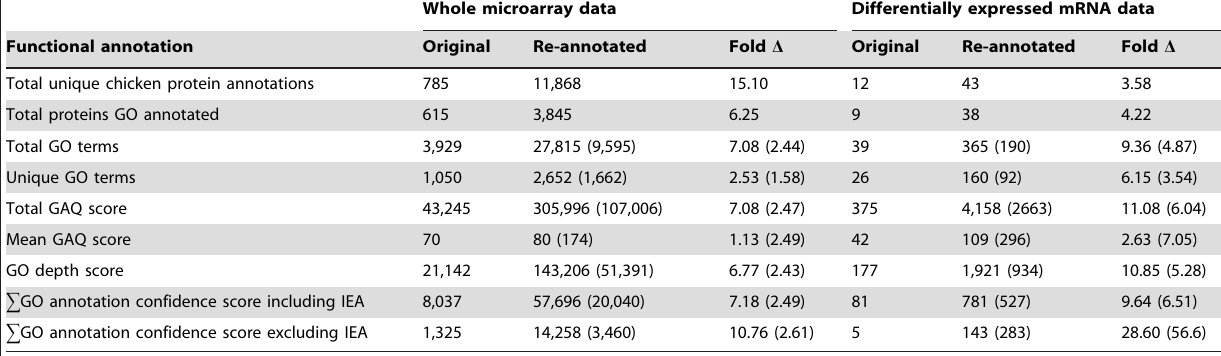
Table 2. Functional re-annotation